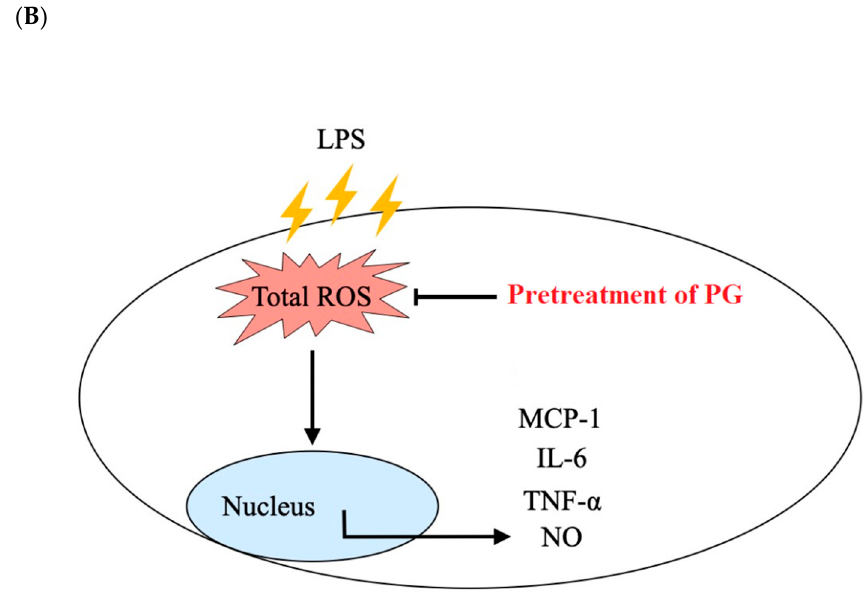
Figure 11. Graphical abstract of our experiments ( A ) and the potential therapeutic mechanism ( B ). In our macrophage-targeted prophylactic model, the pretreatment of purple shoot green tea (PG) effectively scavenge lipopolysaccharide (LPS)-induced reactive oxygen species (ROS) and nitric oxide (NO) through modulating cytokine expressions (MCP-1, IL-6 and TNF- α ) that could serve as a natural product for immunomodulation. MCP-1: Monocyte chemoattractant protein-1; IL-6: Interleukin-6; TNF- α , tumor necrosis factor- α .